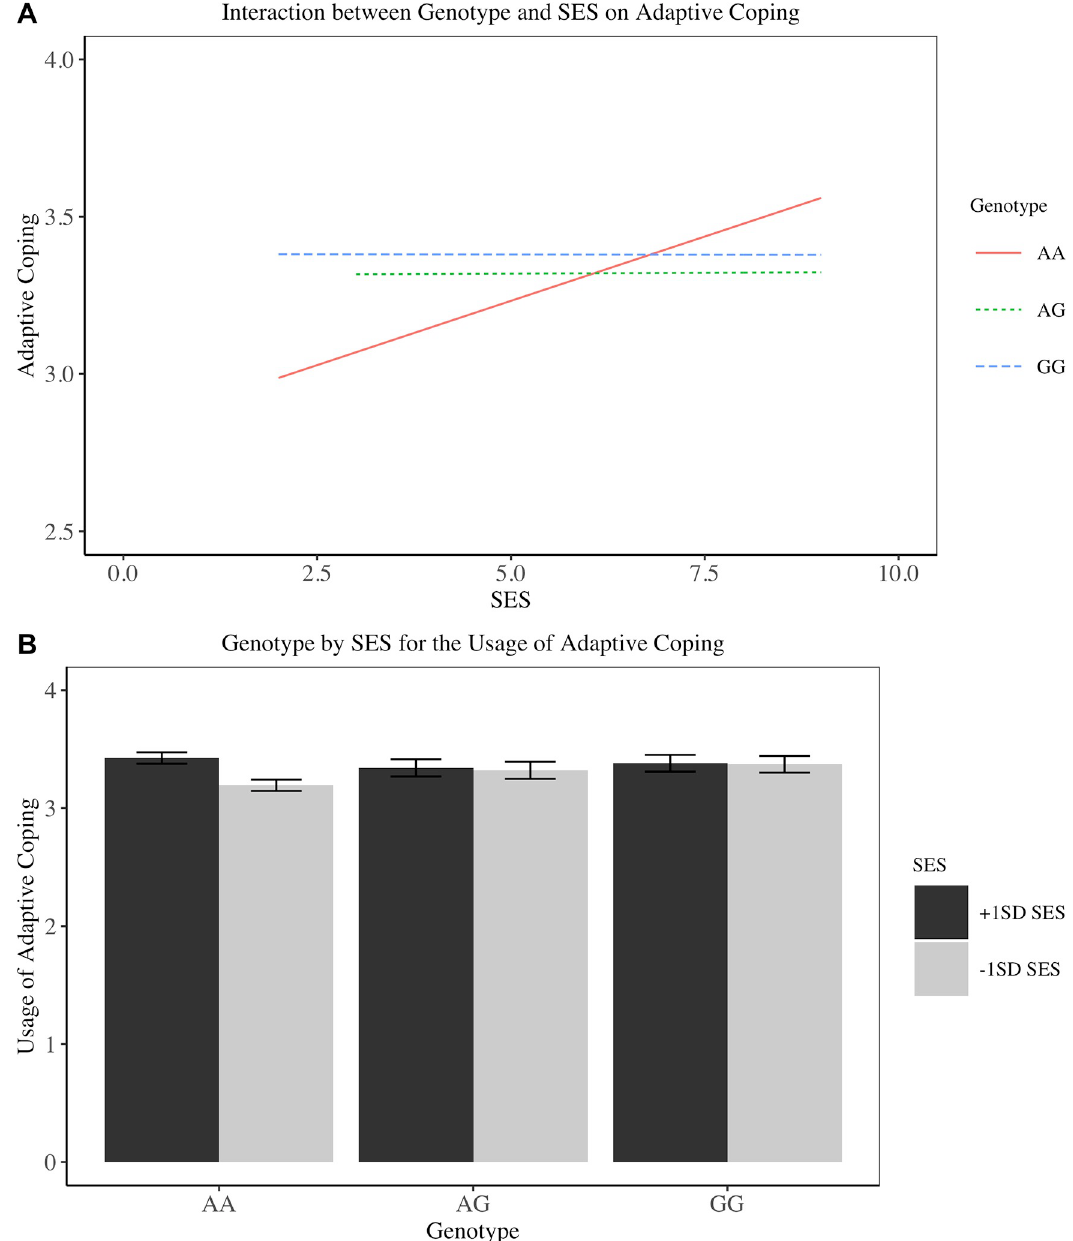
Fig 6. Interaction between genotype and SES on adaptive coping in Study 5. (A) Line plot. (B) Bar plot with standard deviation.